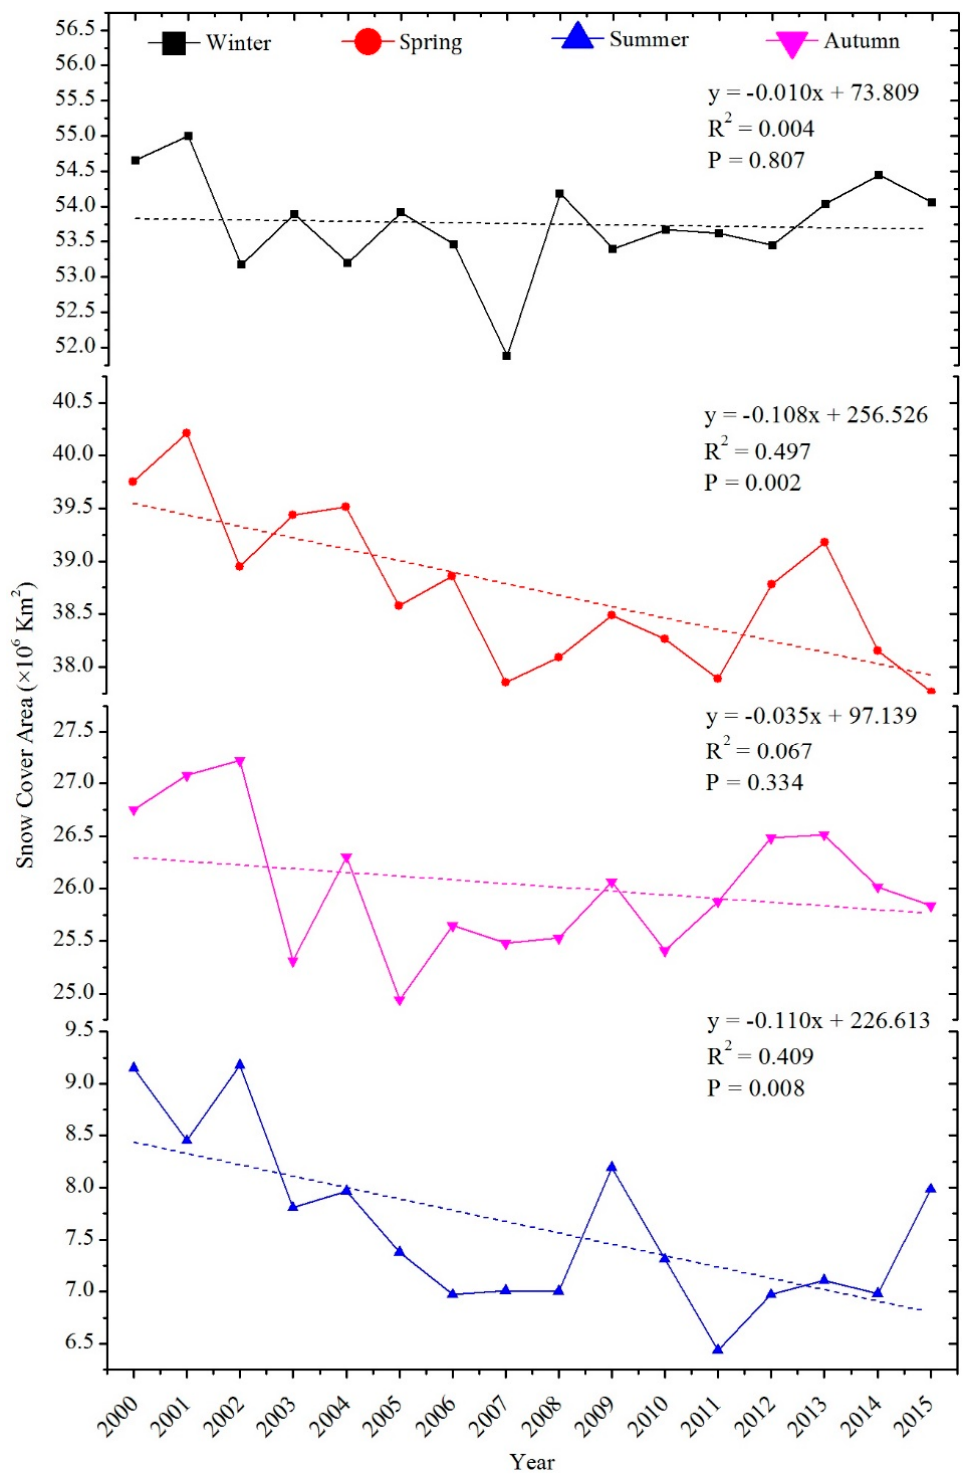
Figure 6. The average area proportion of snow cover in each season in the Northern Hemisphere from 2000 to 2015. 2000 to